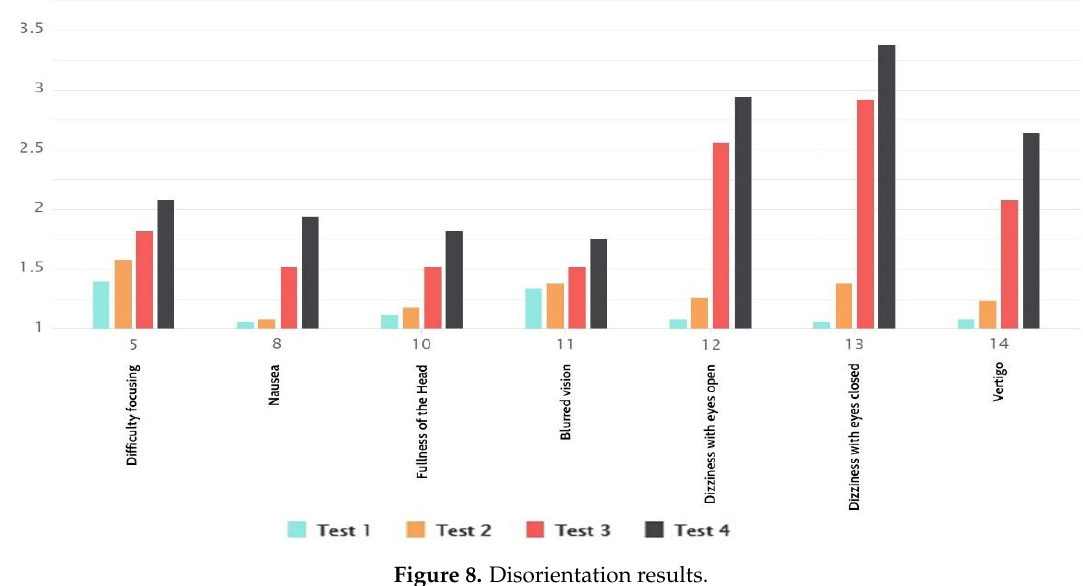
Figure 8. Disorientation results.